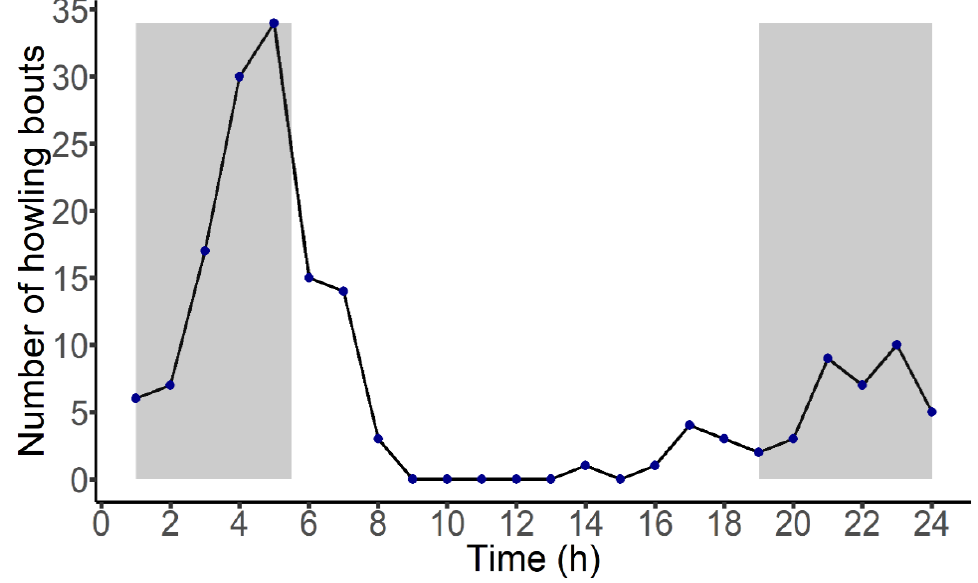
Figure 2. Diel vocal behavior of the Guianan red howler monkey in Viruá National Park, Roraima, Brazil. Diel pattern is expressed as the total number of howling bouts (all groups pooled) detected per recording hour. The graph starts at 0100 h and ends at 2400 h. The gray shaded areas indicate nocturnal hours (1900 h to 0529 h) based on nautical twilight.